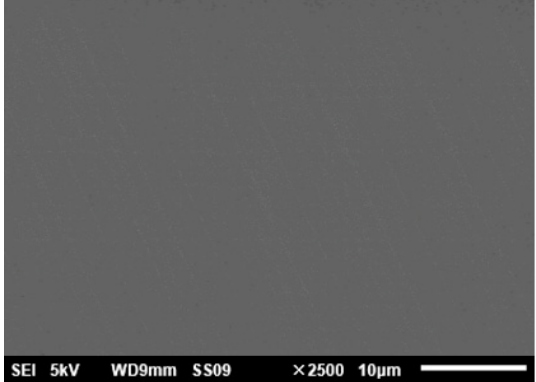
Figure 14. SEM micrograph of the SPDT surface after laser modification.